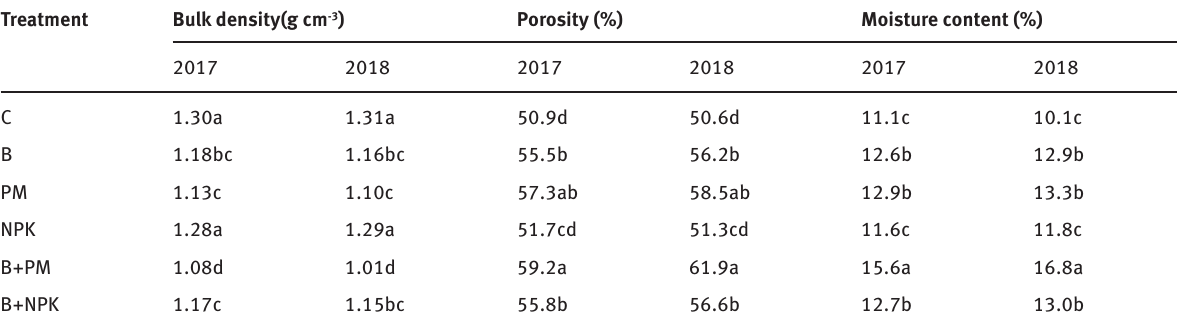
Table 3: Effect of biochar, poultry manure and NPK 15-15-15 fertilizer on soil physical properties